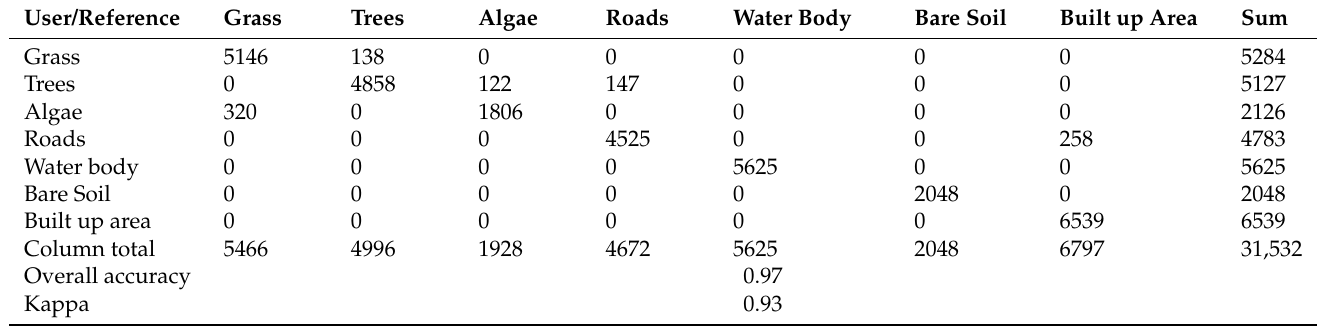
Figure 5. Results of LULC classification for Sydney. Table 5. Error matrix for the accuracy assessment of the Sydney LULC classification.